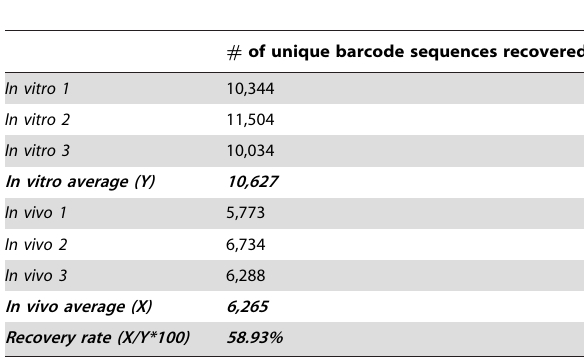
Table 3. Barcode recovery rate from HCT-116 cells in NSG mice and in vitro